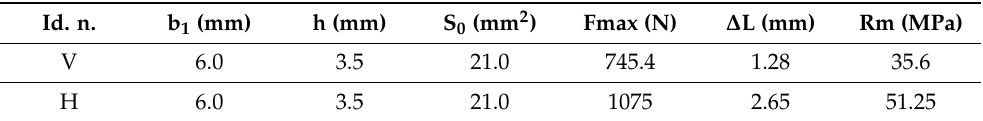
Table 1. The tensile test results of the vertically orientated, V, and the horizontally orientated, H, specimens.